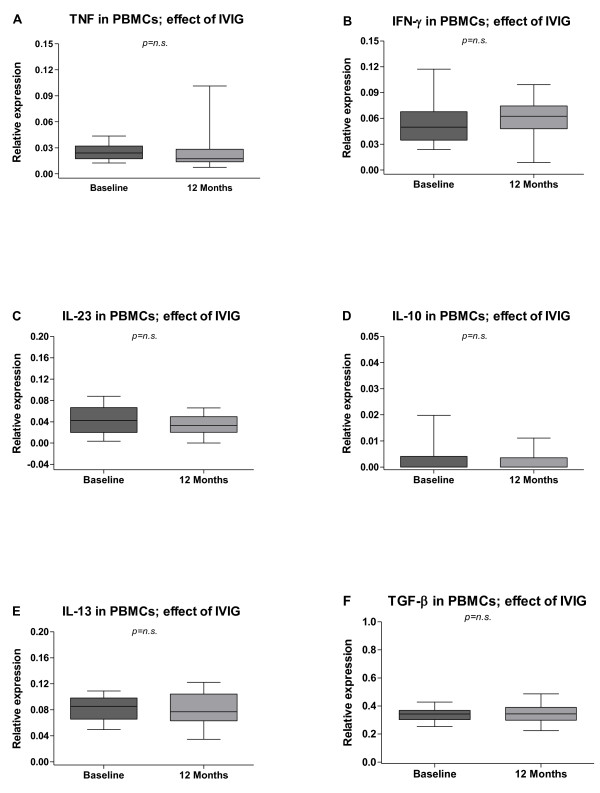
Effects of intravenous immunoglobulin (IVIG) on levels of inflammatory cytokines in peripheral blood mononuclear cells (PBMCs). The median-based box plots indicate 25th/75th percentiles and whiskers indicate 5th/95th percentiles. Values of statistical significance are indicted (n.s.: non significant).